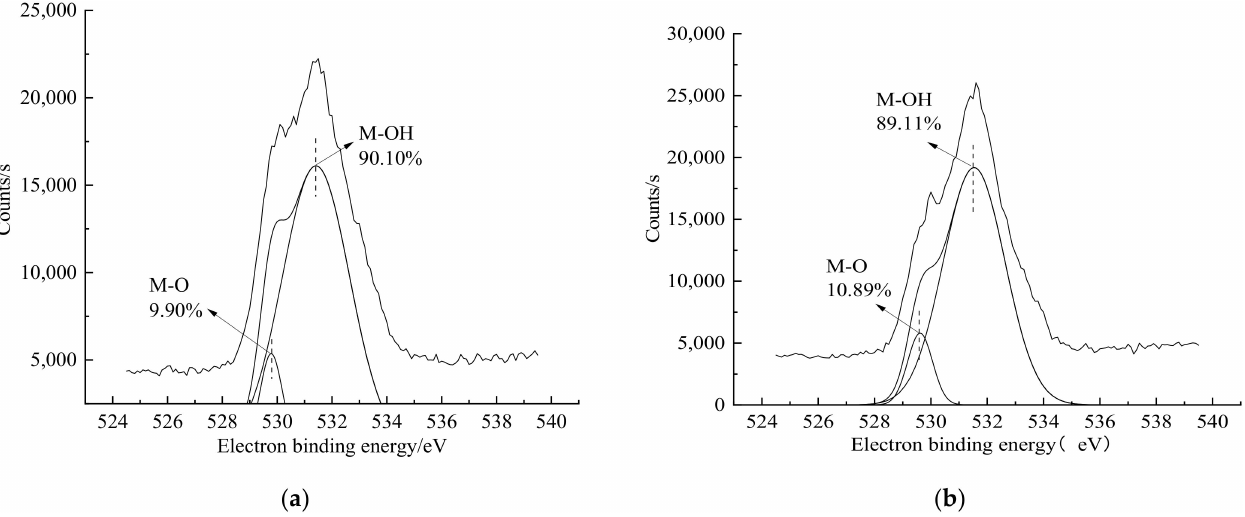
Figure 5. XPS spectra of O1s before ( a ) and after ( b ) phosphorus removal by composite adsorbent.